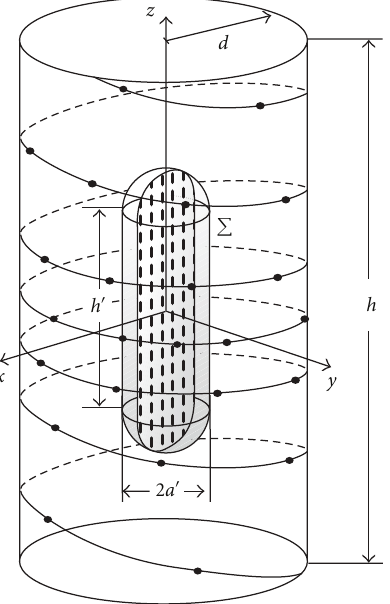
Figure 16: Helicoidal scanning: the rounded cylinder modelling.